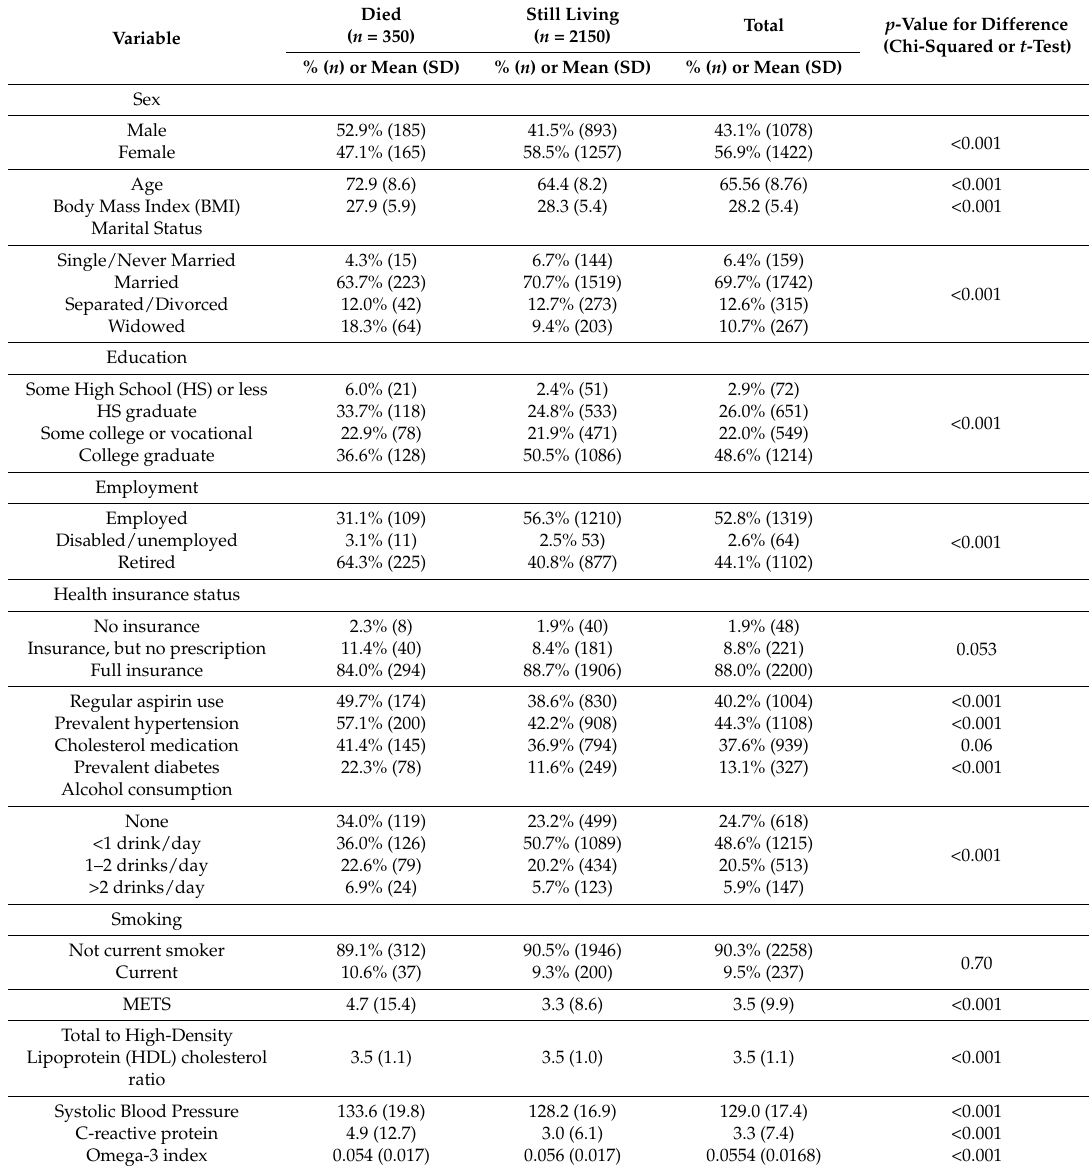
Table 1. Demographic overview ( n = 2500). METS: metabolic